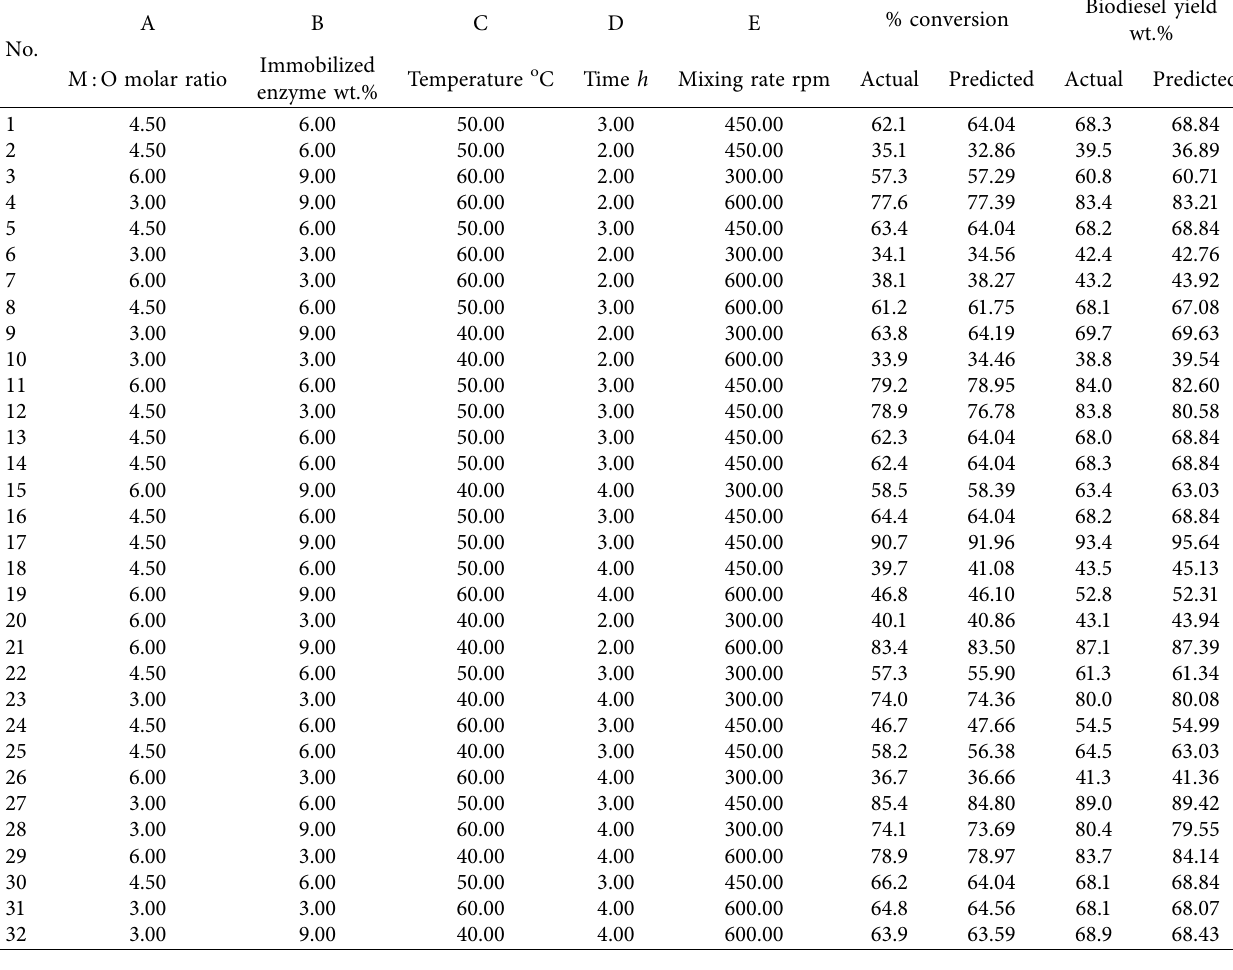
Table 1: Design of experiments for the transesterifcation process using E–NH values.